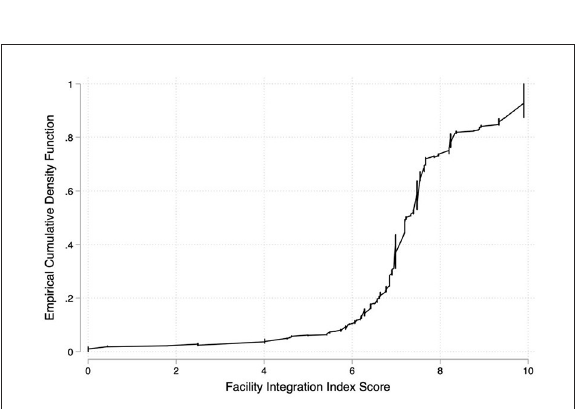
FIGUREA2 Facility integration index cumulative